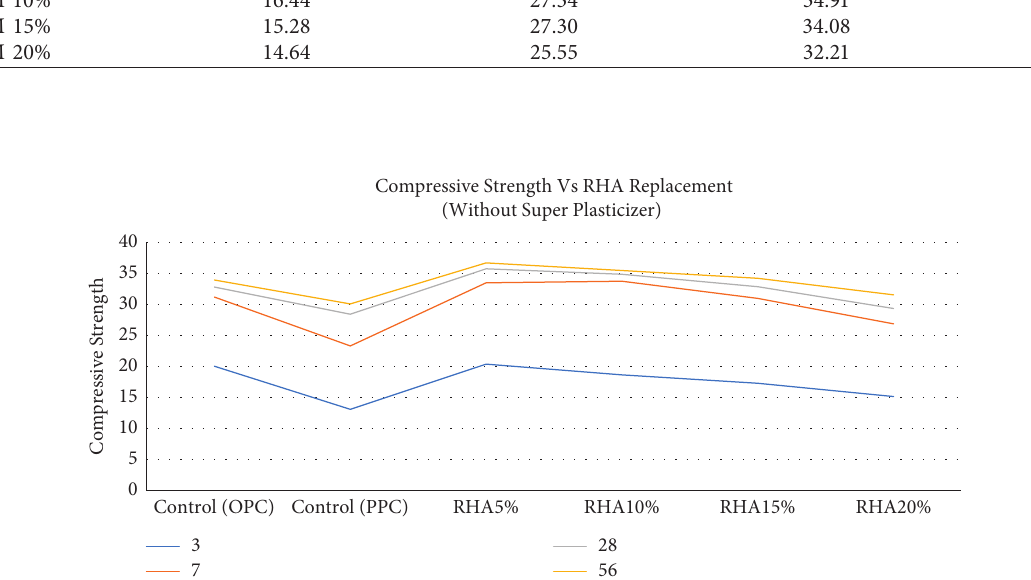
Figure 6: Compressive strength vs. RHA replacement for concretes without superplasticizing admixture.